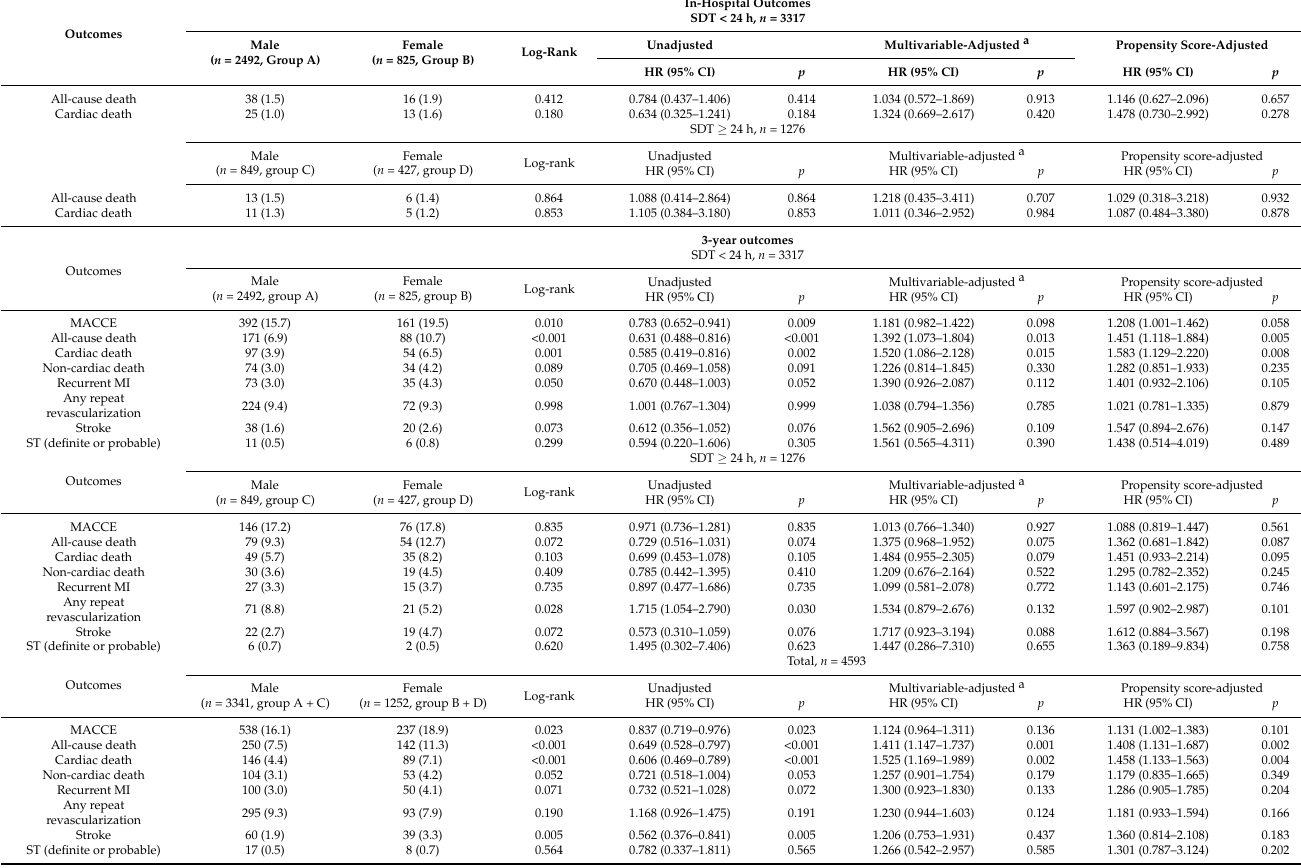
Table 2. Clinical outcomes between male and female groups in patient with or without delayed